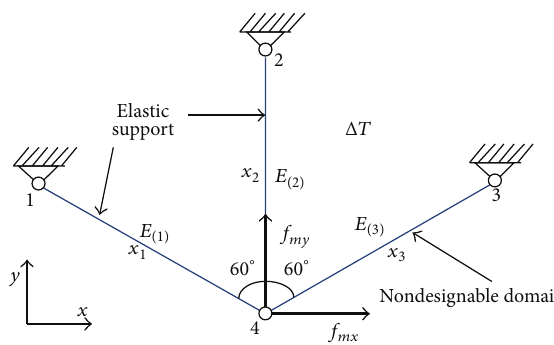
Figure 2: Three-bar truss system with elastic